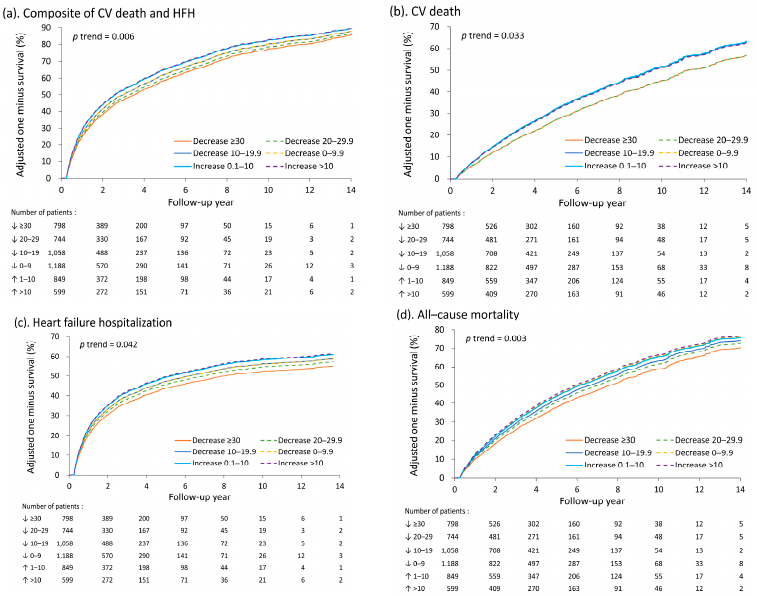
Figure 2. Adjusted (fitted) one minus survival for the composite outcome of cardiovascular death and HHF ( a ), cardiovascular death ( b ), HHF ( c ), and all-cause mortality ( d ) among patients with different changes in heart rate from discharge to 3-month screening period. HHF, hospitalization for heart failure; CV, cardiovascular.